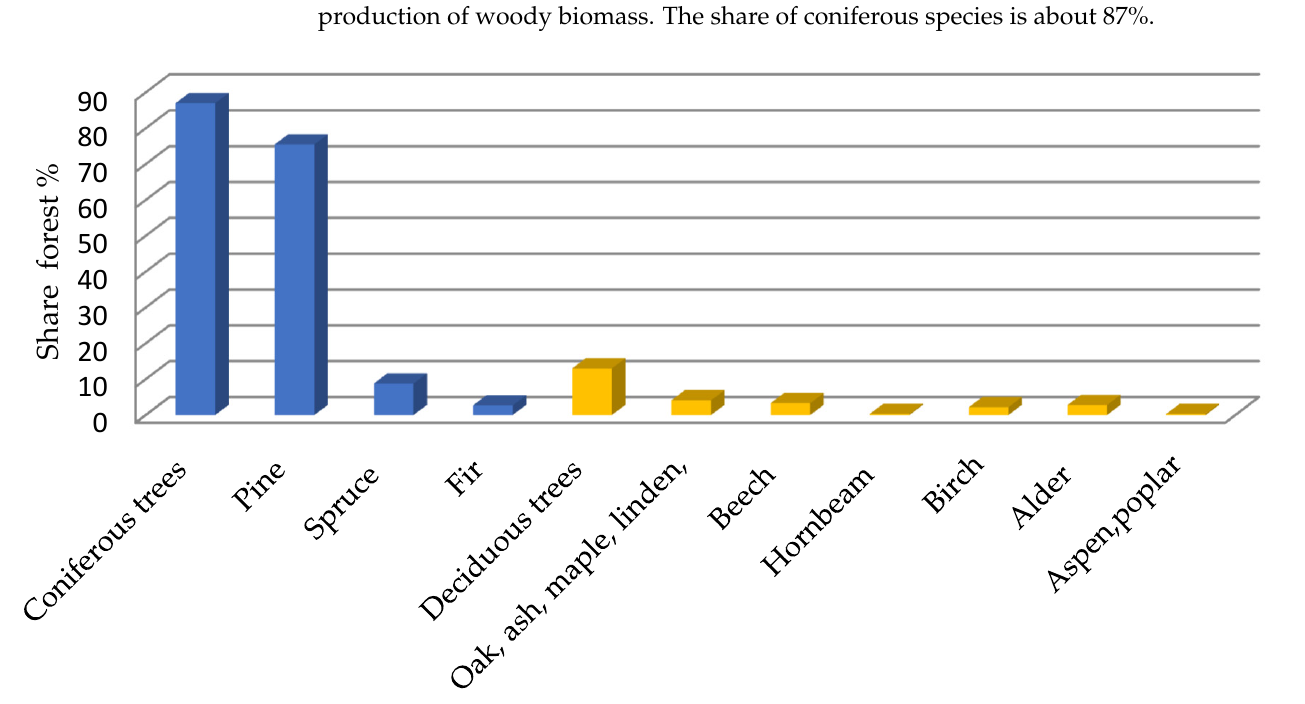
spruce 8%, fir 4.4%, beech 3%, oak 4%, birch 2%, and other 10.8% ( Statistical Yearbook of Forestry 2020